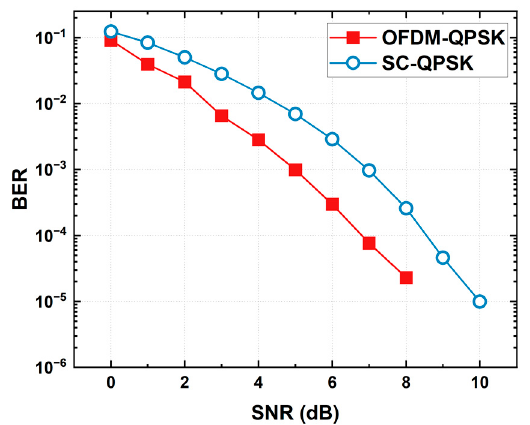
Figure 4. BER curves of the OFDM-QPSK signal and the SC-QPSK signal.